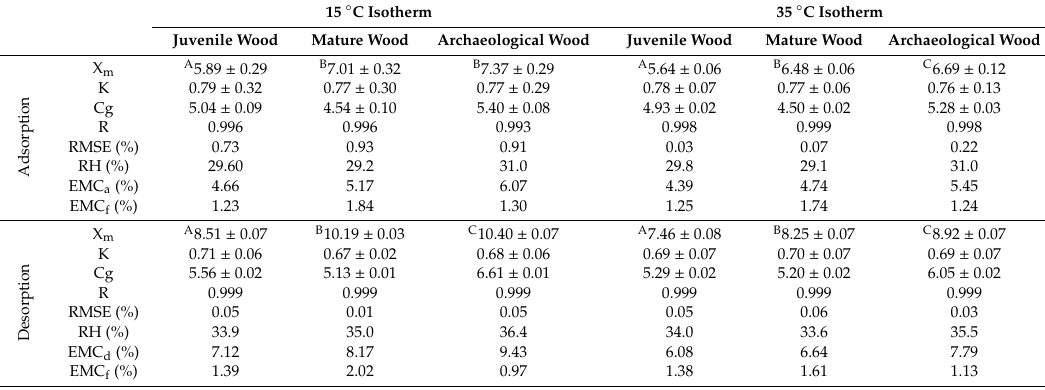
Table 2. Main functional groups present in wood and their absorption band.